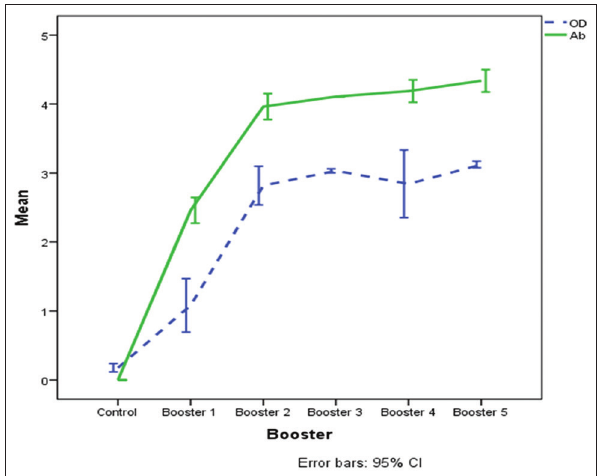
Figure-1: Level of optical density value and antibody titer (immunoglobulin G) of rabbit resulted from immunization with soluble mite protein.